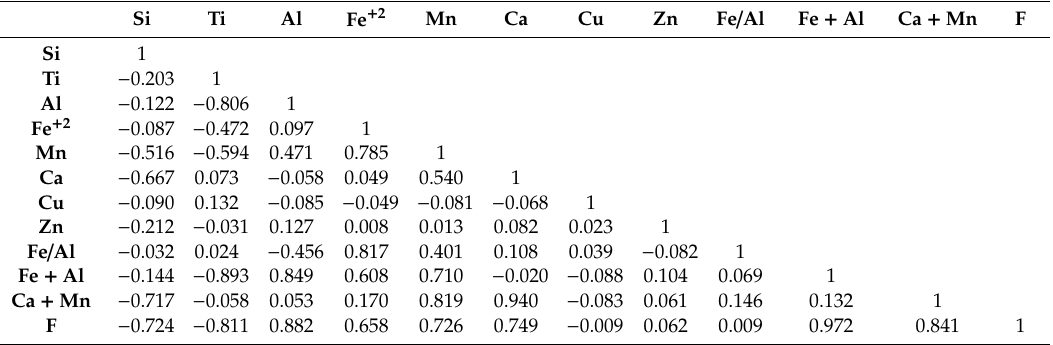
Table A2. Correlation matrix of titanite compositions from unmineralized